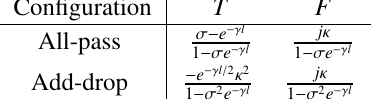
Table 1: Transmission (T) and Field Enhancement (F)